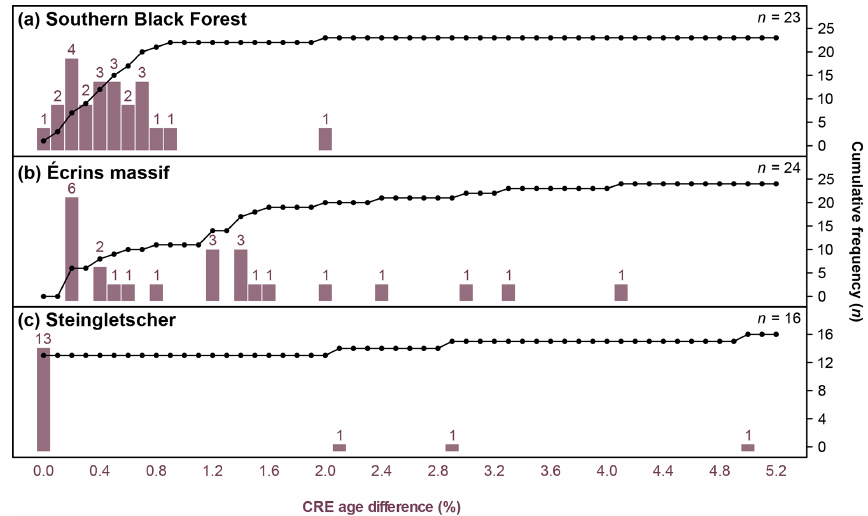
Figure 8. Histogram of differences in CRE ages for the (a) southern Black Forest, the (b) the Écrins massif and the forefield of (c) Stein-